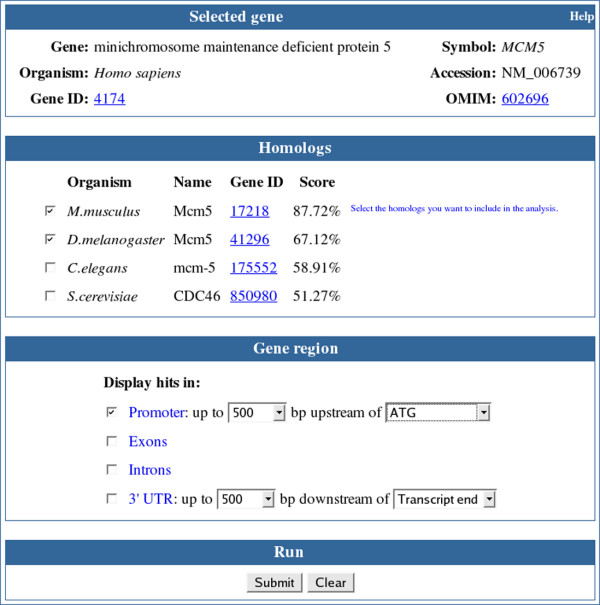
The selection page of the search engine. The selection page for the MCM5 gene displays detailed information on the gene and its homologs available in our database, and allows the user to select the gene region to be scanned. The same region will be scanned for all homologs included in the search.